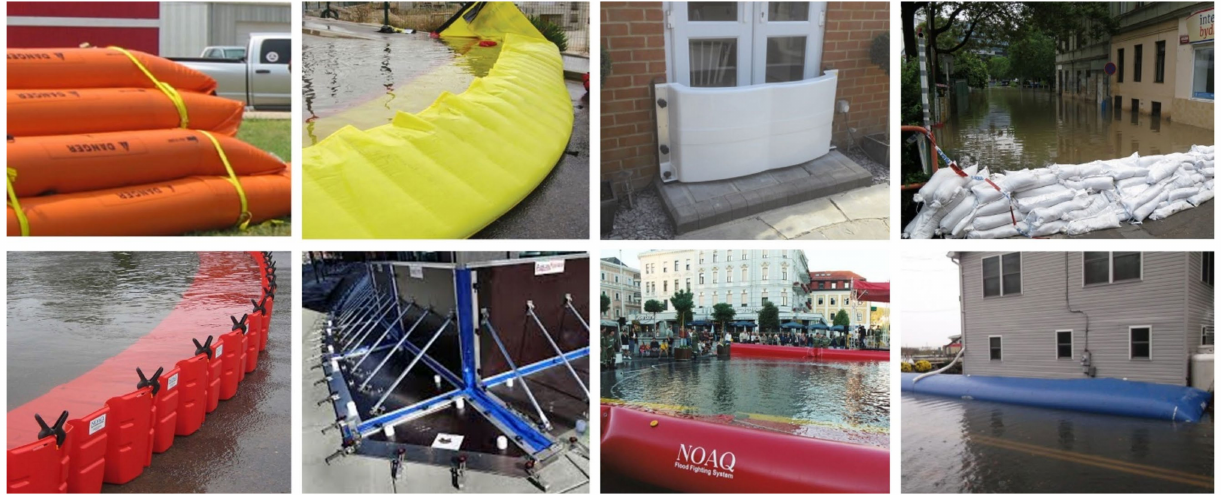
Figure 6. Different types of flood barrier systems.